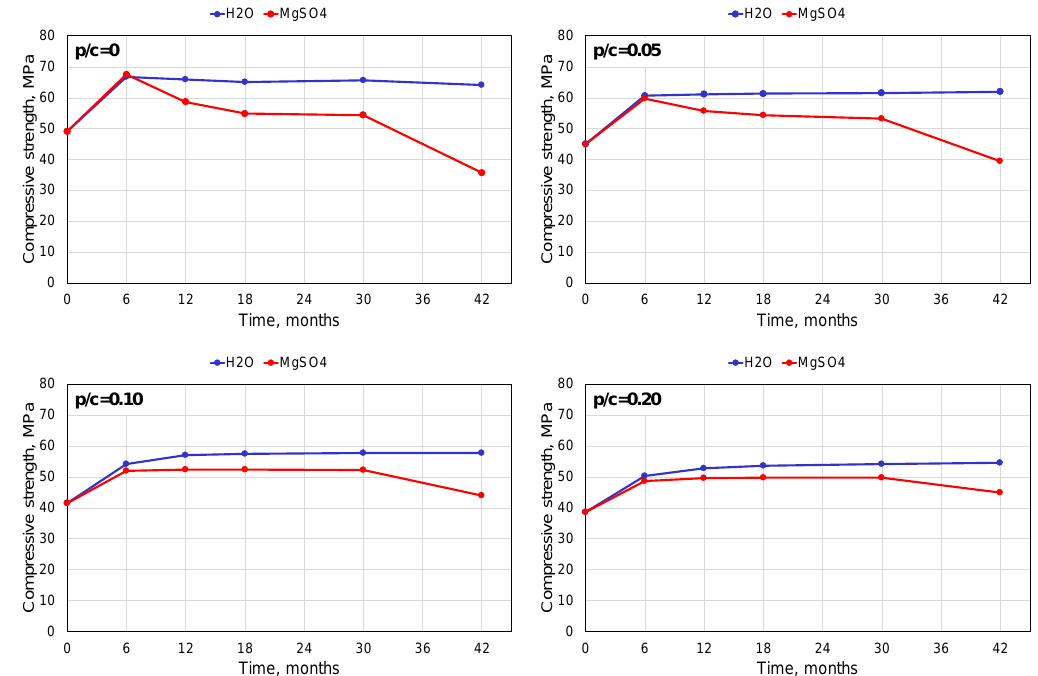
Figure 4. Compressive strength of mortars exposed to 5% MgSO 4 solution and distilled water.